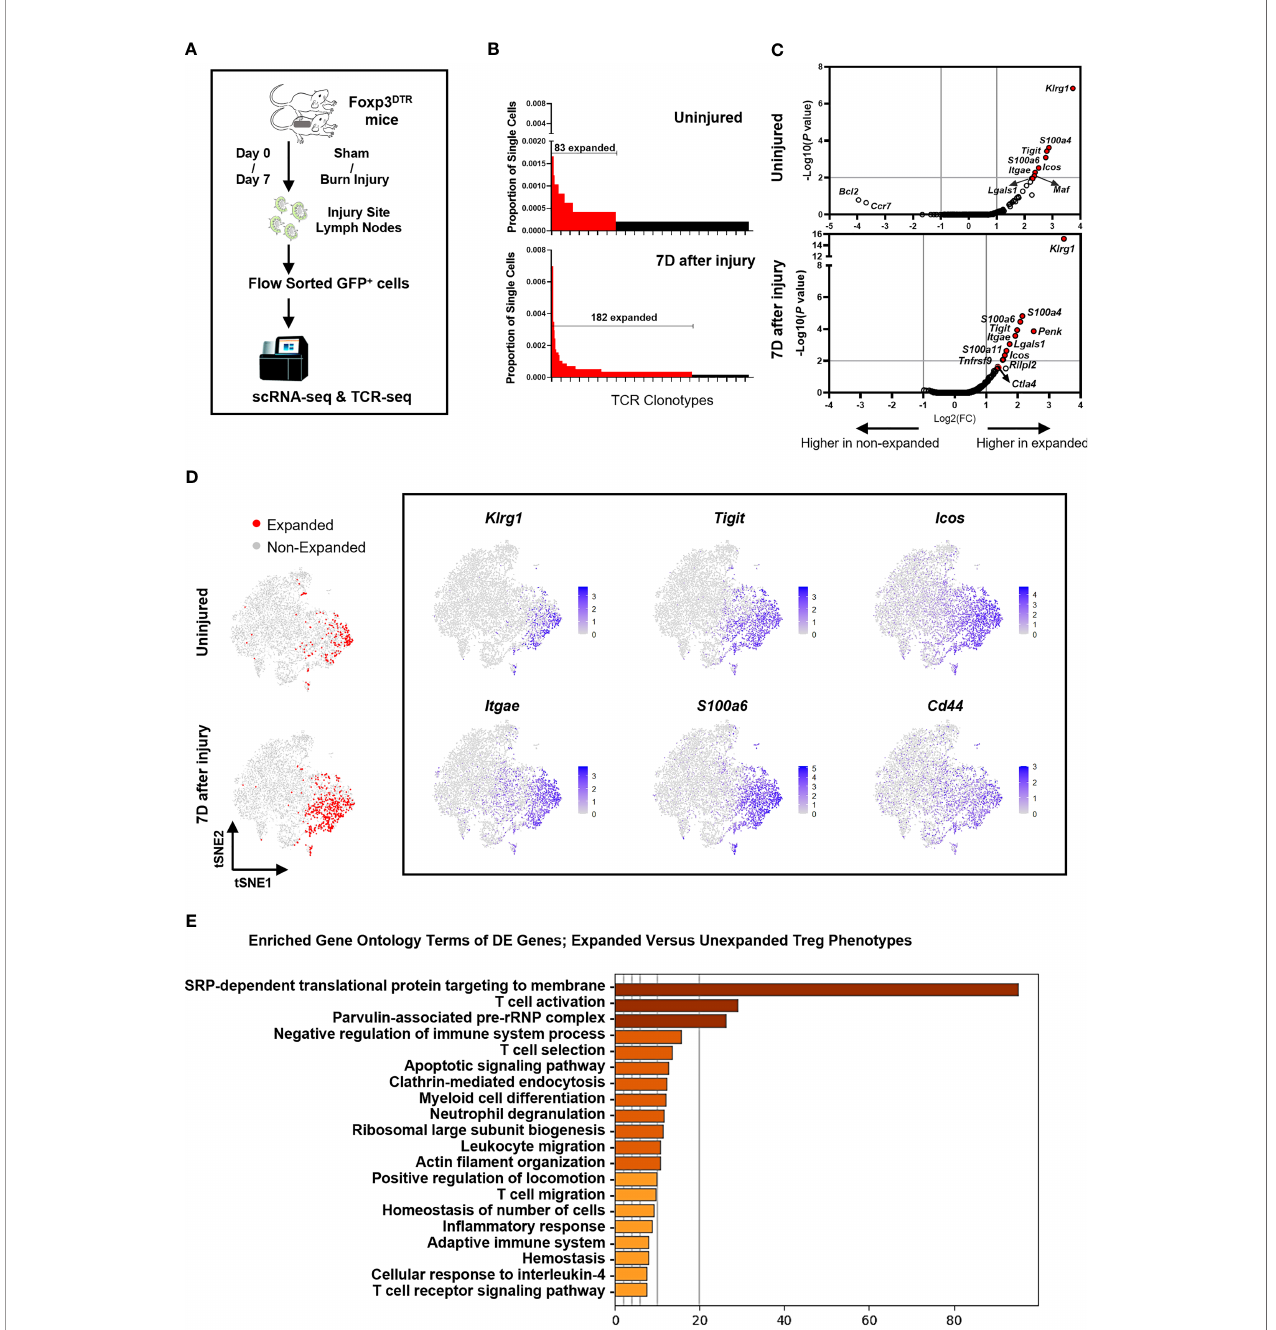
FIGURE 4 | Injury induces a KLRG1 + Treg subset with expanded TCR clonotypes. (A) Experimental scheme of scRNAseq and scTCRseq analysis of FACS sorted FoxP3-GFP + Tregs from the lymph nodes of mice at 7 days after sham or burn trauma injury. (B) Comparison of the frequencies of the top 255 TCR clonotypes in Tregs from uninjured and injured mice. Red bars depict expanded (>2) TCR clonotypes. (C) Volcano plots showing genes that are differentially expressed between expanded and non-expanded Tregs from uninjured and injured mice. (D) tSNE plots showing the location of expanded Tregs identi fi ed by TCR sequencing, as well as the expression of 6 highly differentially expressed genes in injury expanded Tregs. (E) Bar plots showing enriched gene ontology (GO) terms that are signi fi cantly different between clusters of expanded versus unexpanded Tregs. These GO term plots were generated using the Metascape gene annotation and analysis resource